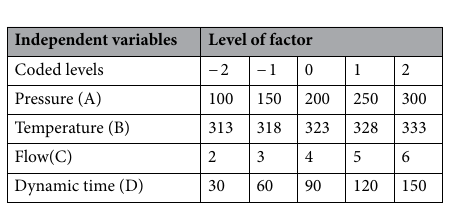
Table 1. Un-coded and coded levels of parameters employed in the